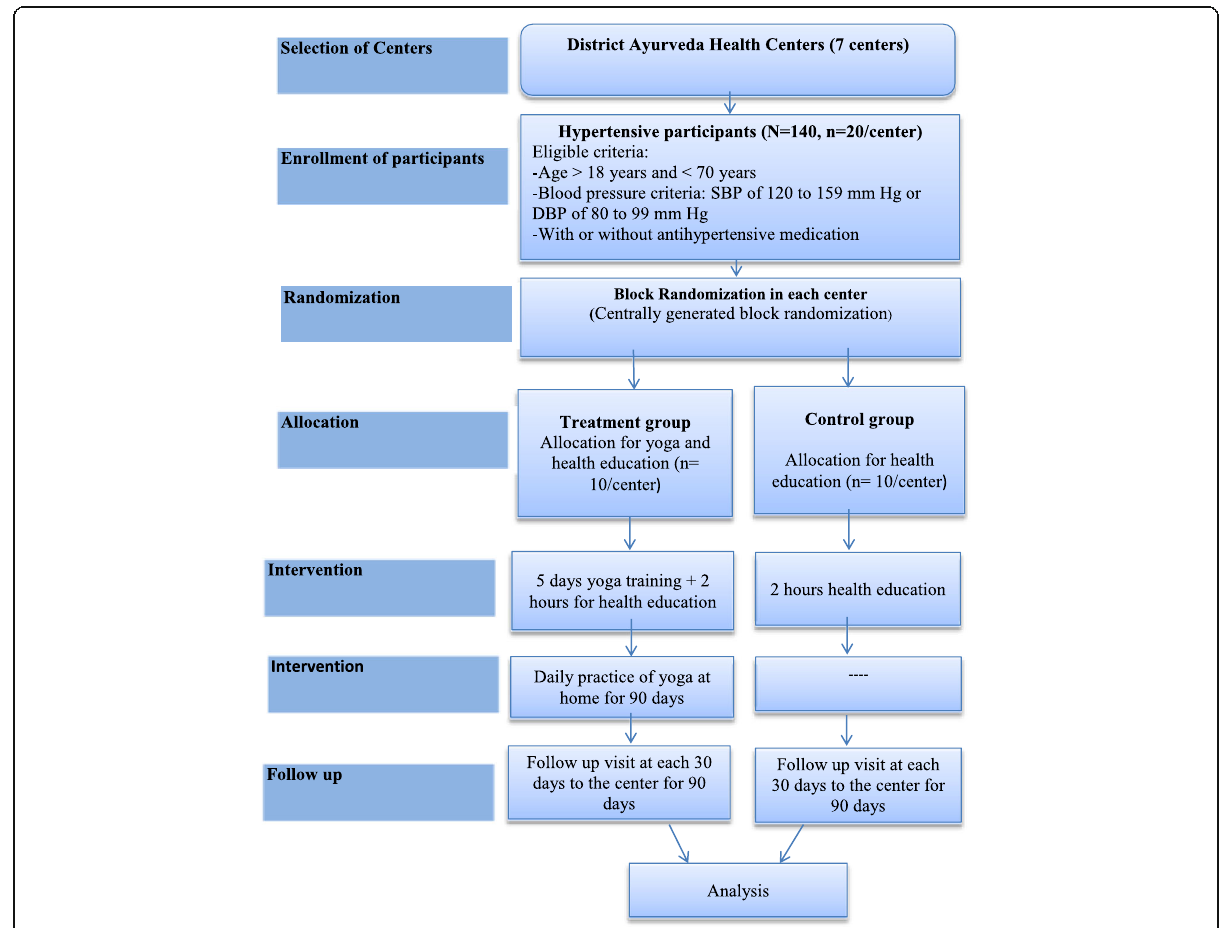
Fig. 2 Flow chart of phases of study. Total 140 study participants from seven study sites (20 per site) will be enrolled in the study. Both arms (treatment and control) will contain equal numbers of participants (10 in each arm) at each center (through stratified block